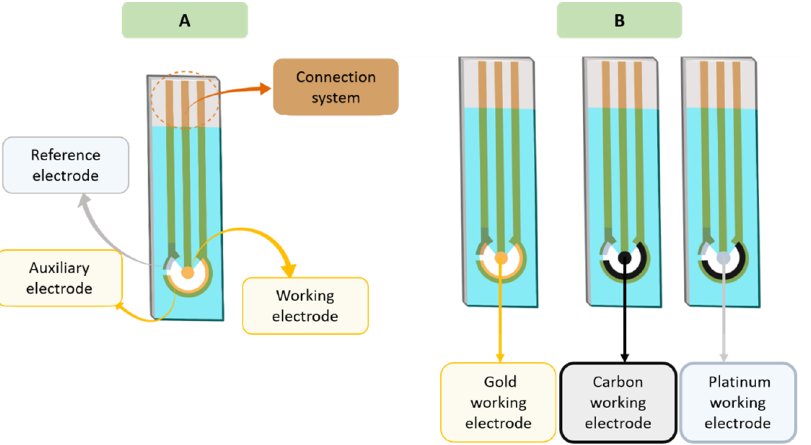
Figure 1. ( A ) Screen-printed electrode device with three different electrodes: a working electrode, reference electrode and auxiliary/counter electrode; ( B ) types of materials used for manufacturing the working electrode. Created with BioRender.com accessed on 29 March 2022 .